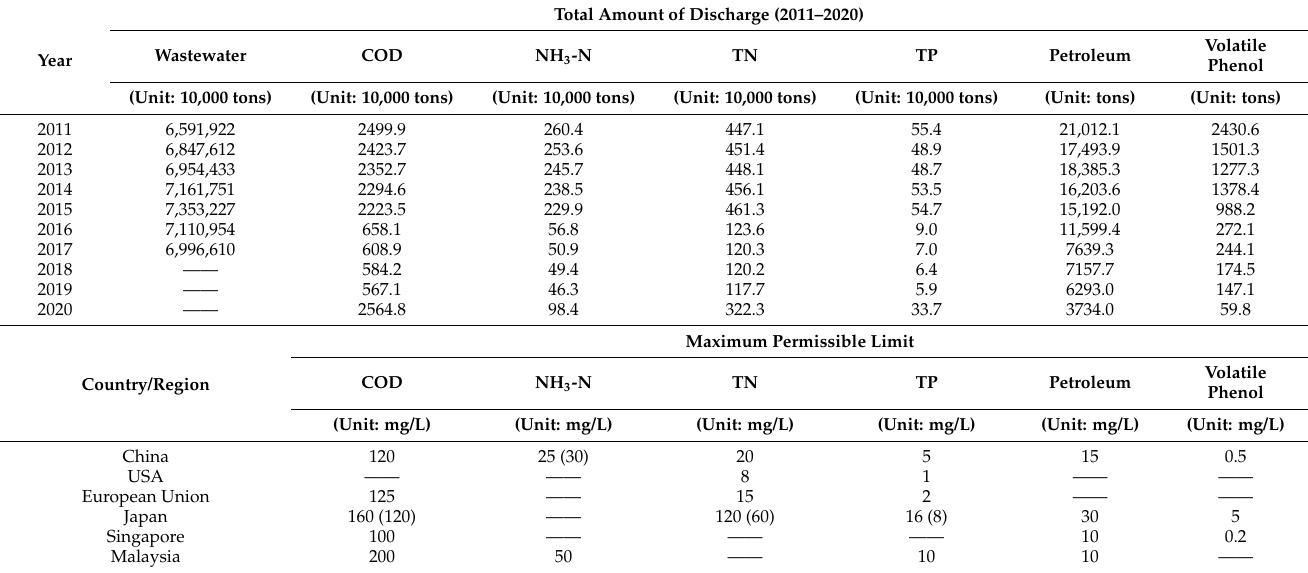
Table 6. China’s wastewater discharge, key pollutants, and permissible limit